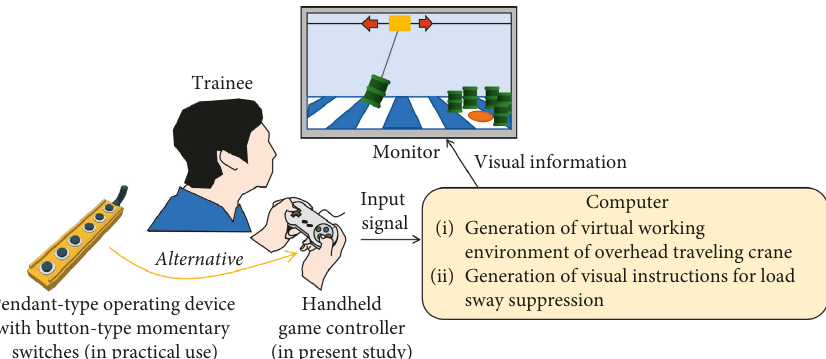
Figure 2: Overview of the operational training simulator of overhead traveling